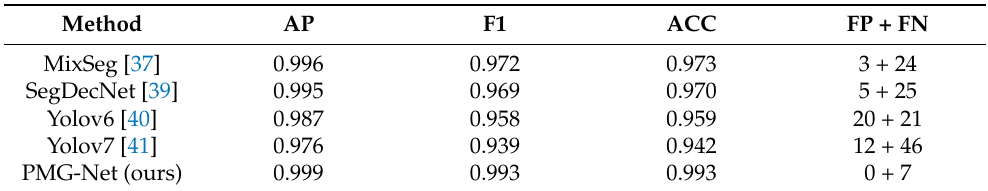
Table 4. The accuracy results of these five methods on the bearing dataset.